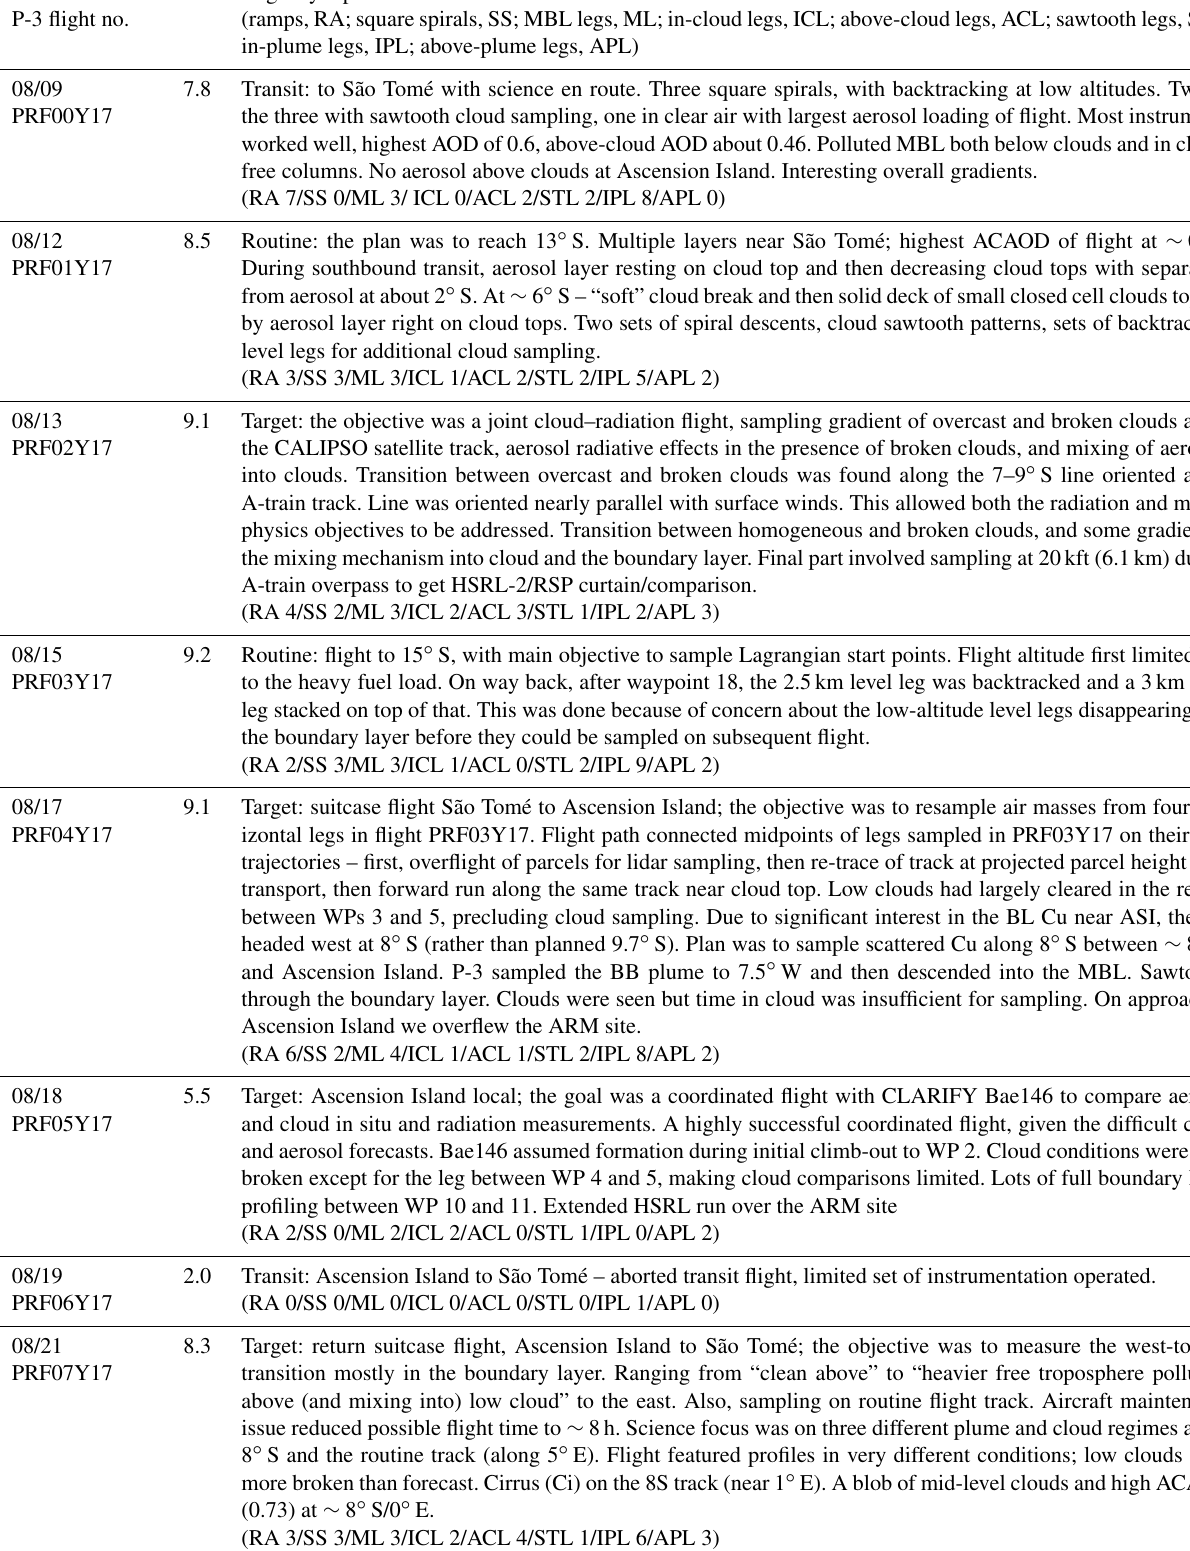
Table A2. The 2017 flight summary for the P-3 aircraft. Date h Flight synopsis P-3 flight no. (ramps, RA; square spirals, SS; MBL legs, ML; in-cloud legs, ICL; above-cloud legs, ACL; sawtooth legs, STL; in-plume legs, IPL; above-plume legs,